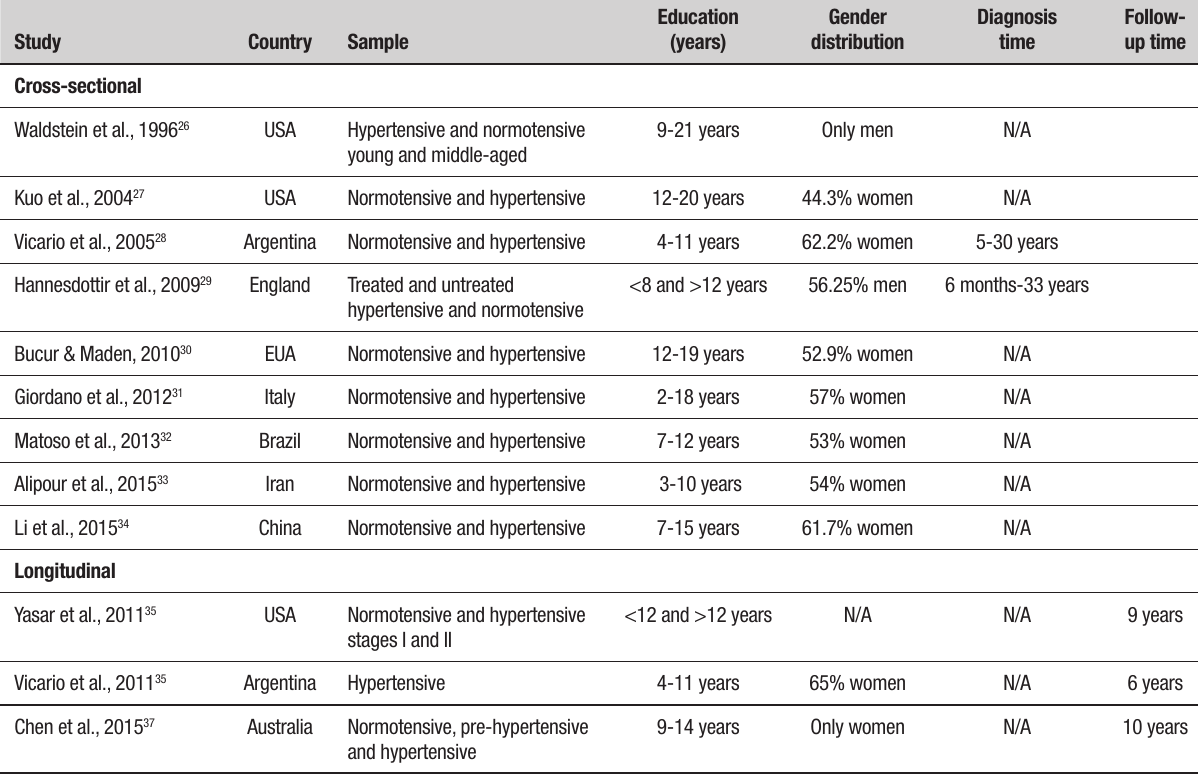
Table 2. Main characteristics of selected